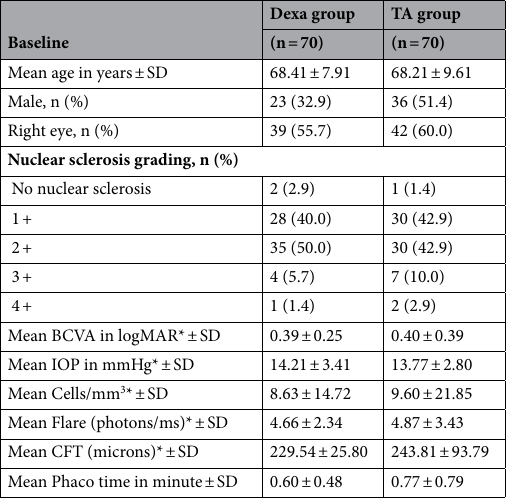
Table 1. Baseline demographic characteristics of the patients in comparison groups. Dexa group = 0.1% dexamethasone eye drop group; TA group = subtenon 20-mg triamcinolone injection group. BCVA best- corrected visual acuity, logMAR logarithm of the minimum angle of resolution, IOP intraocular pressure, CFT central foveal thickness, Phaco phacoemulsification, SD standard deviation. *Preoperative